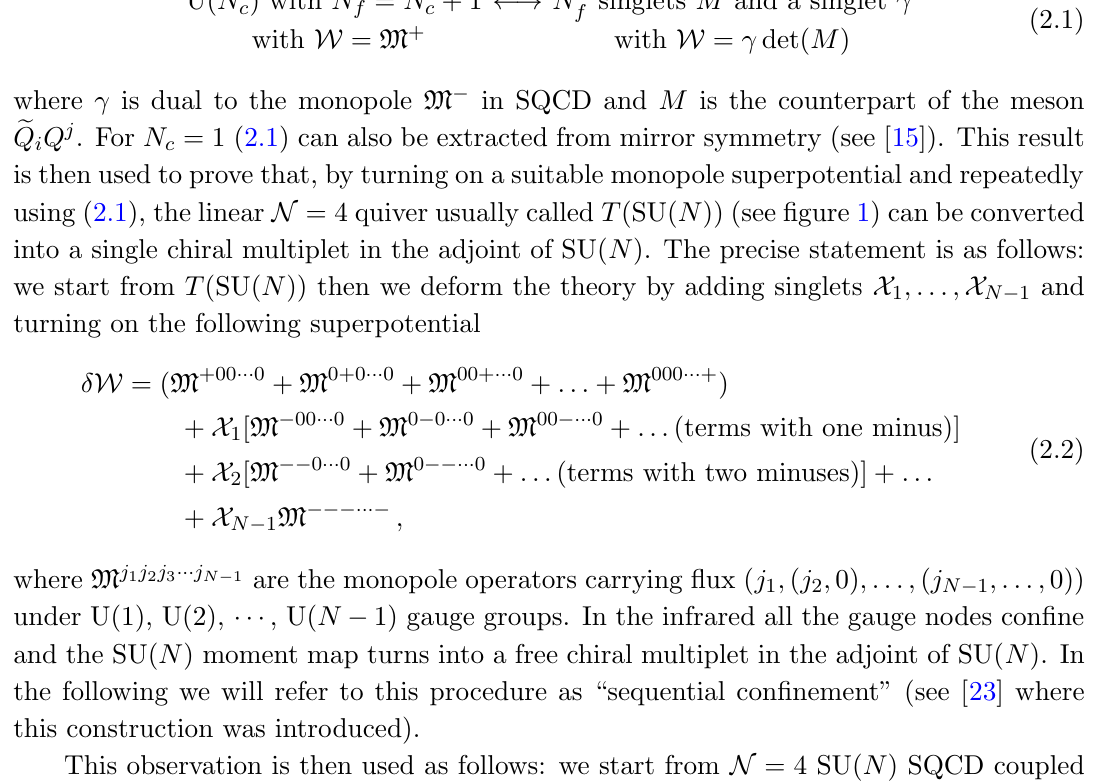
Figure 1. The T (SU( N )) theory. As is customary, a number n inside a circle denotes a U( n ) gauge group and a line connecting two nodes a bifundamental hypermultiplet. The number inside a square denotes the number of hypermultiplets in the fundamental of the gauge group. We will use this notation throughout the paper. Unless otherwise speci(cid:12)ed, it should always be assumed (also when we discuss N = 2 theories) that the spectrum includes a chiral multiplet in the adjoint representation for every gauge